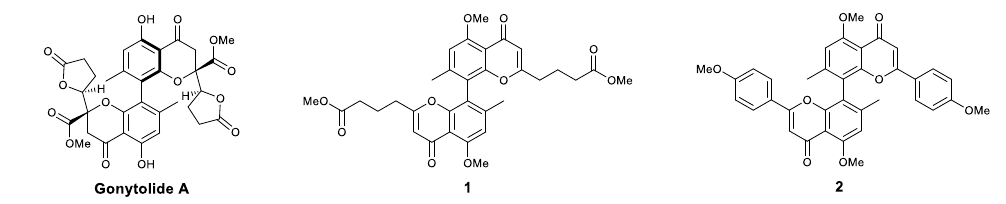
Figure 12. Structures of icariin and rutin.